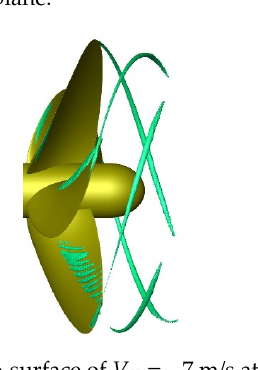
= − 7 m / s at J = Figure 18. Iso-surface of V Z = − 7 m/s at J = 0.7. Figure 18. Iso-surface of V Z Figure 18. Iso-surface of V Z = − 7 m/s at J = 0.7.